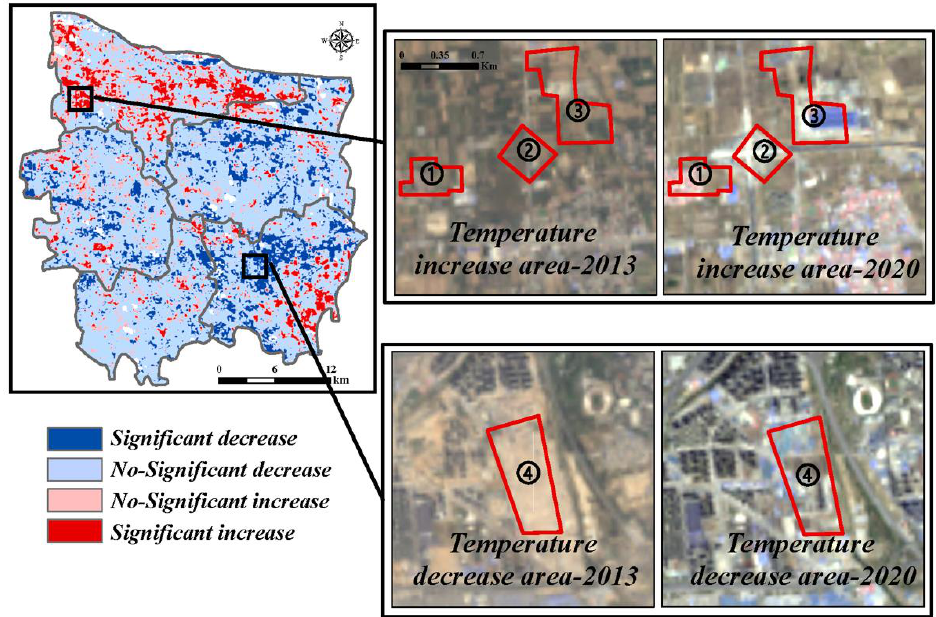
Figure 7. Surface inversion temperature one-dimensional linear regression results. In the figure, ①②③④ are the remote sensing image changes in the area of significant temperature change, where ①②③ is the change of bare land to buildings, and ④ is the change of bare land to green land and water